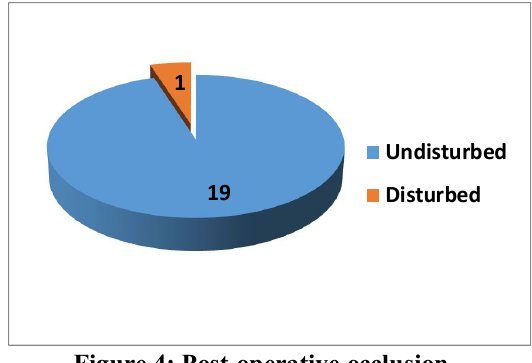
Figure 4: Post-operative occlusion